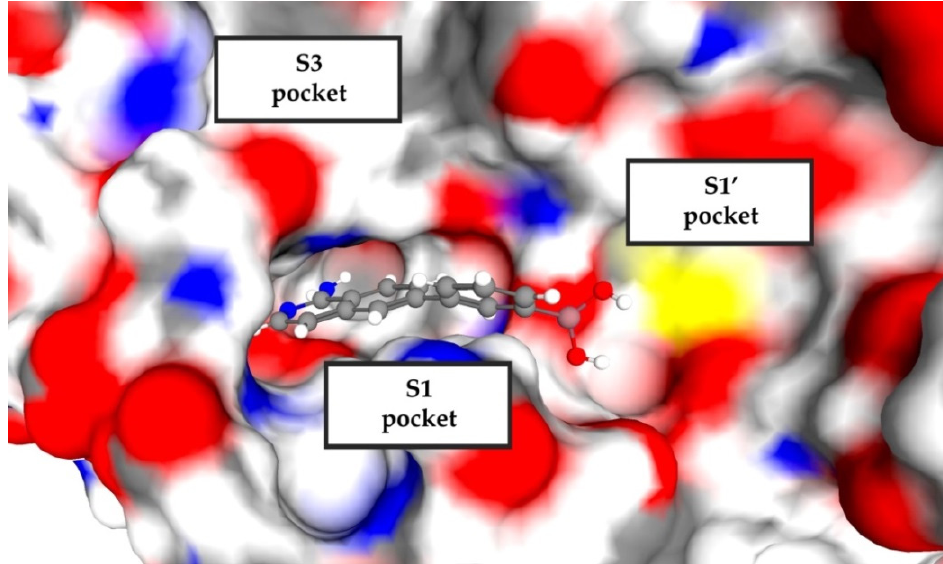
Figure 3. The active site of coagulation factor XIIa (PDB ID: 6B77) with the crystallized native ligand; the protein active site with pockets S1, S1’, and S3 is represented by the solvent accessible surface, and different areas of the surface are colored in accordance with the types of protein atoms located nearby: red—oxygen; gray—carbon; blue—nitrogen; white—hydrogen; and yellow—sulfur